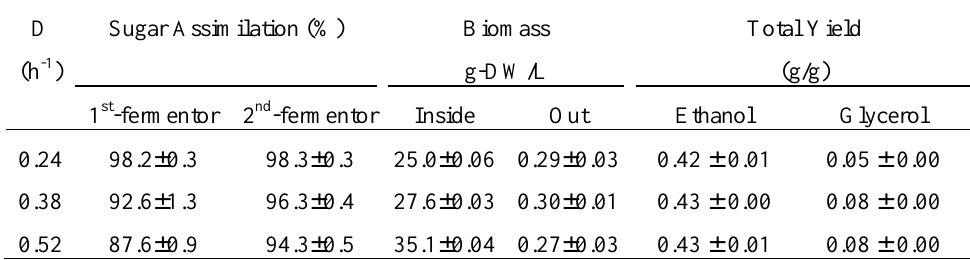
Table 3 . The performance of flocculating yeast in continuous cultivation of dilute-acid hydrolyzate in a serial bioreactor equipped with recycling system (Figure 1B) at different dilution rates. The dilution rates are based on the total volume of both